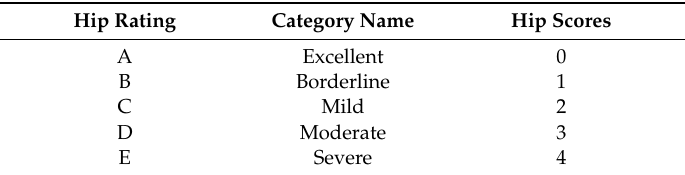
Table 1. Categories and code numbers of canine hip dysplasia.